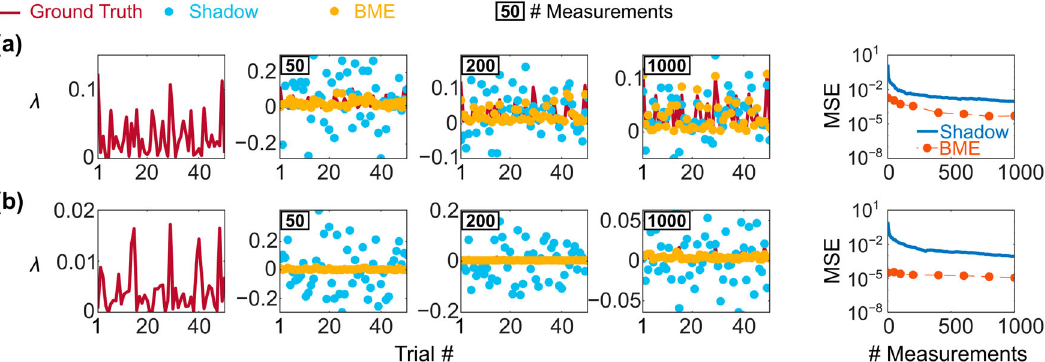
Fig. 2 Estimating rank-1 observable Λ for randomly chosen ground truth states (Picture 2). a D = 32 case. b D = 256 case. The fi rst four columns show λ values for each trial; the last column plots MSE with respect to ground truth over all